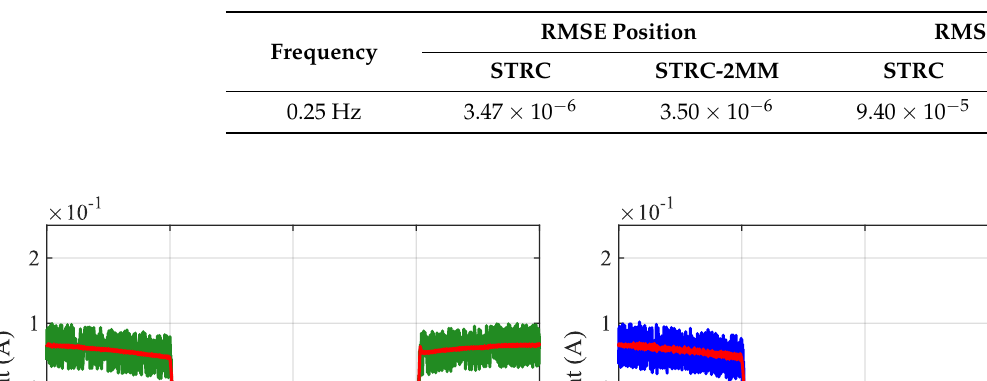
Table 5. Root mean square error for one full period at a frequency of 0.25 Hz comparing STRC and STRC-2MM models.